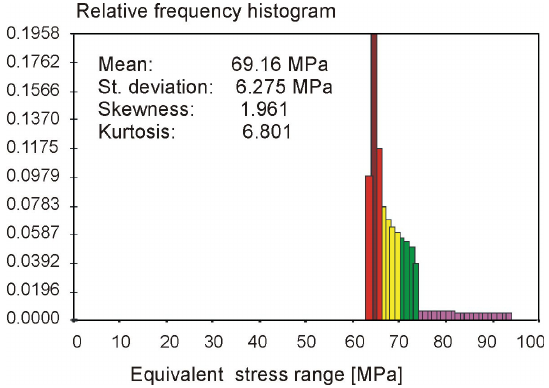
Fig. 6. Density function of equivalent stress range